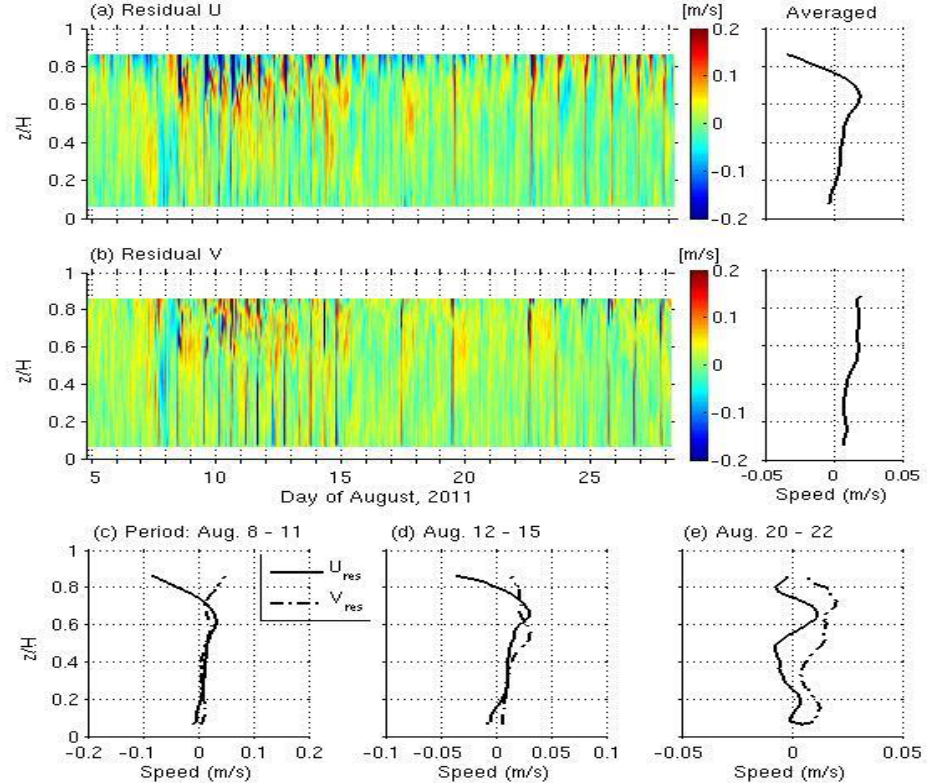
Figure 3. Change of vertical structure of the residual (tide-removed) flow: ( a ) east–west component, ( b ) north–south component, and mean flow structure of each period such as ( c ) high (i.e., Q > 4 × 10 7 ton on August 8–11), ( d ) low (i.e., Q < 1 × 10 7 ton on August 12–15), and ( e ) no freshwater discharge (August 20–22). Two profiles on the right side of ( a ) and ( b ) are the residual over the entire period. The negative values on ( a ) and ( b ) indicate west- and south-directed residual velocities, respectively.